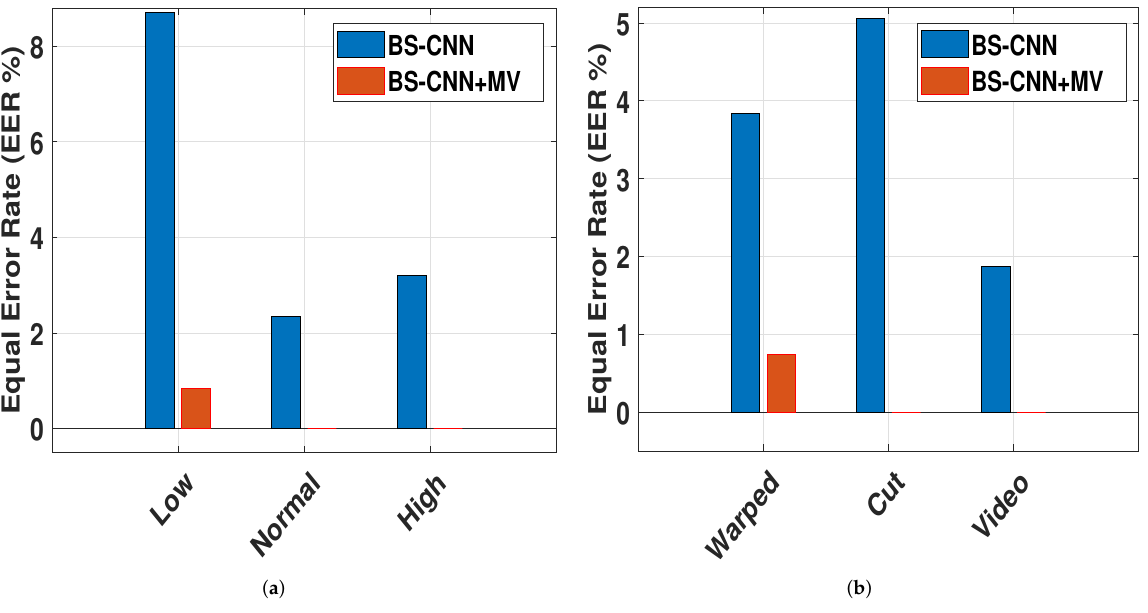
Figure 6. Effect of quality and spoofing media on the performance on the CASIA-FASD. ( a ) Quality and ( b ) spoofing